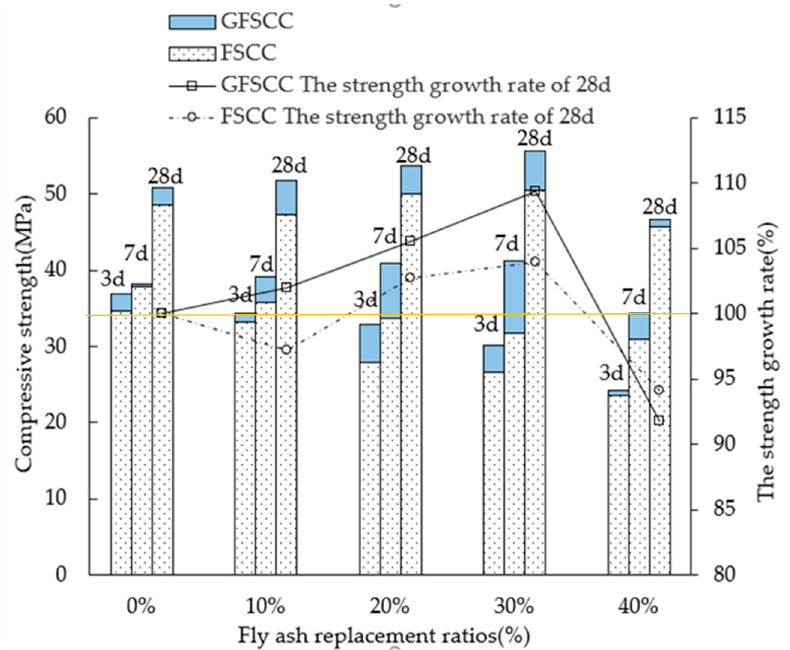
Figure 3. Compressive strength and growth rate of SCC.